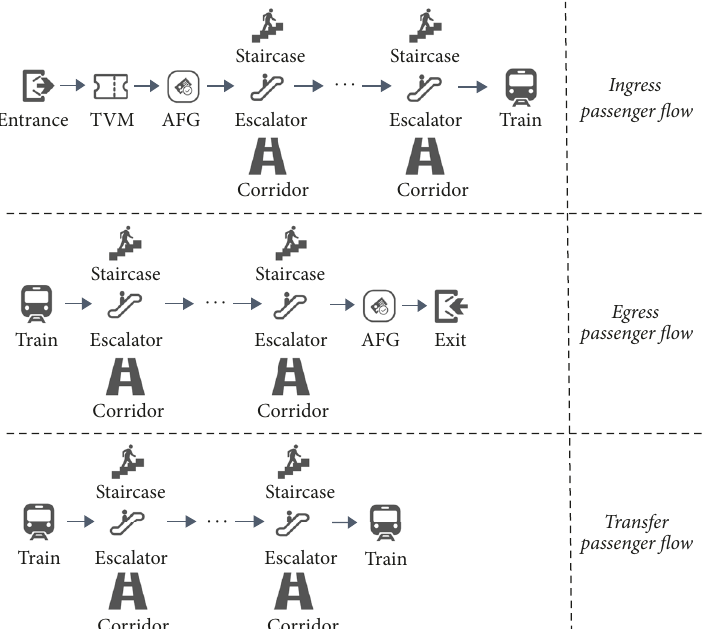
Figure 1: Illustration for facility chains in station.